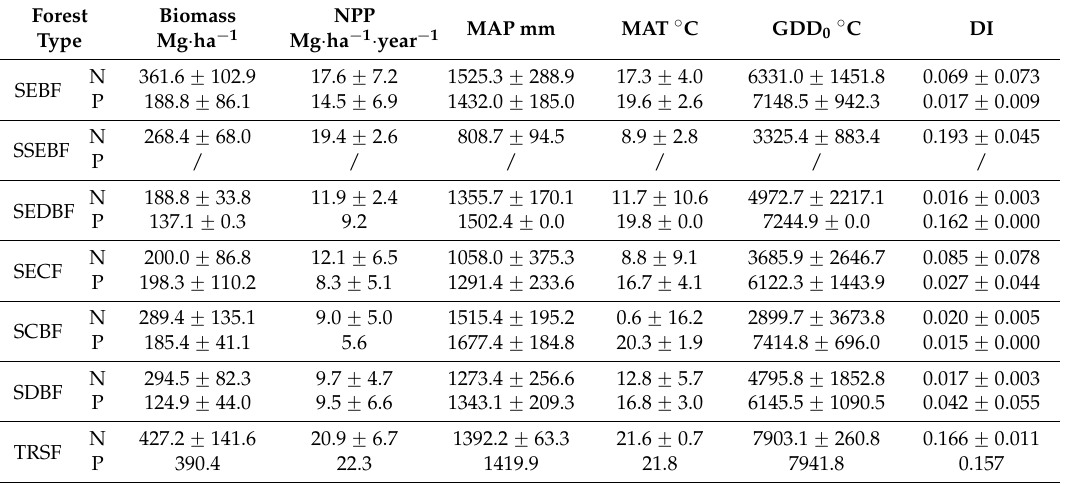
Table 3. Summary of biomass and NPP together with key climate variables in Southwestern China. Forest